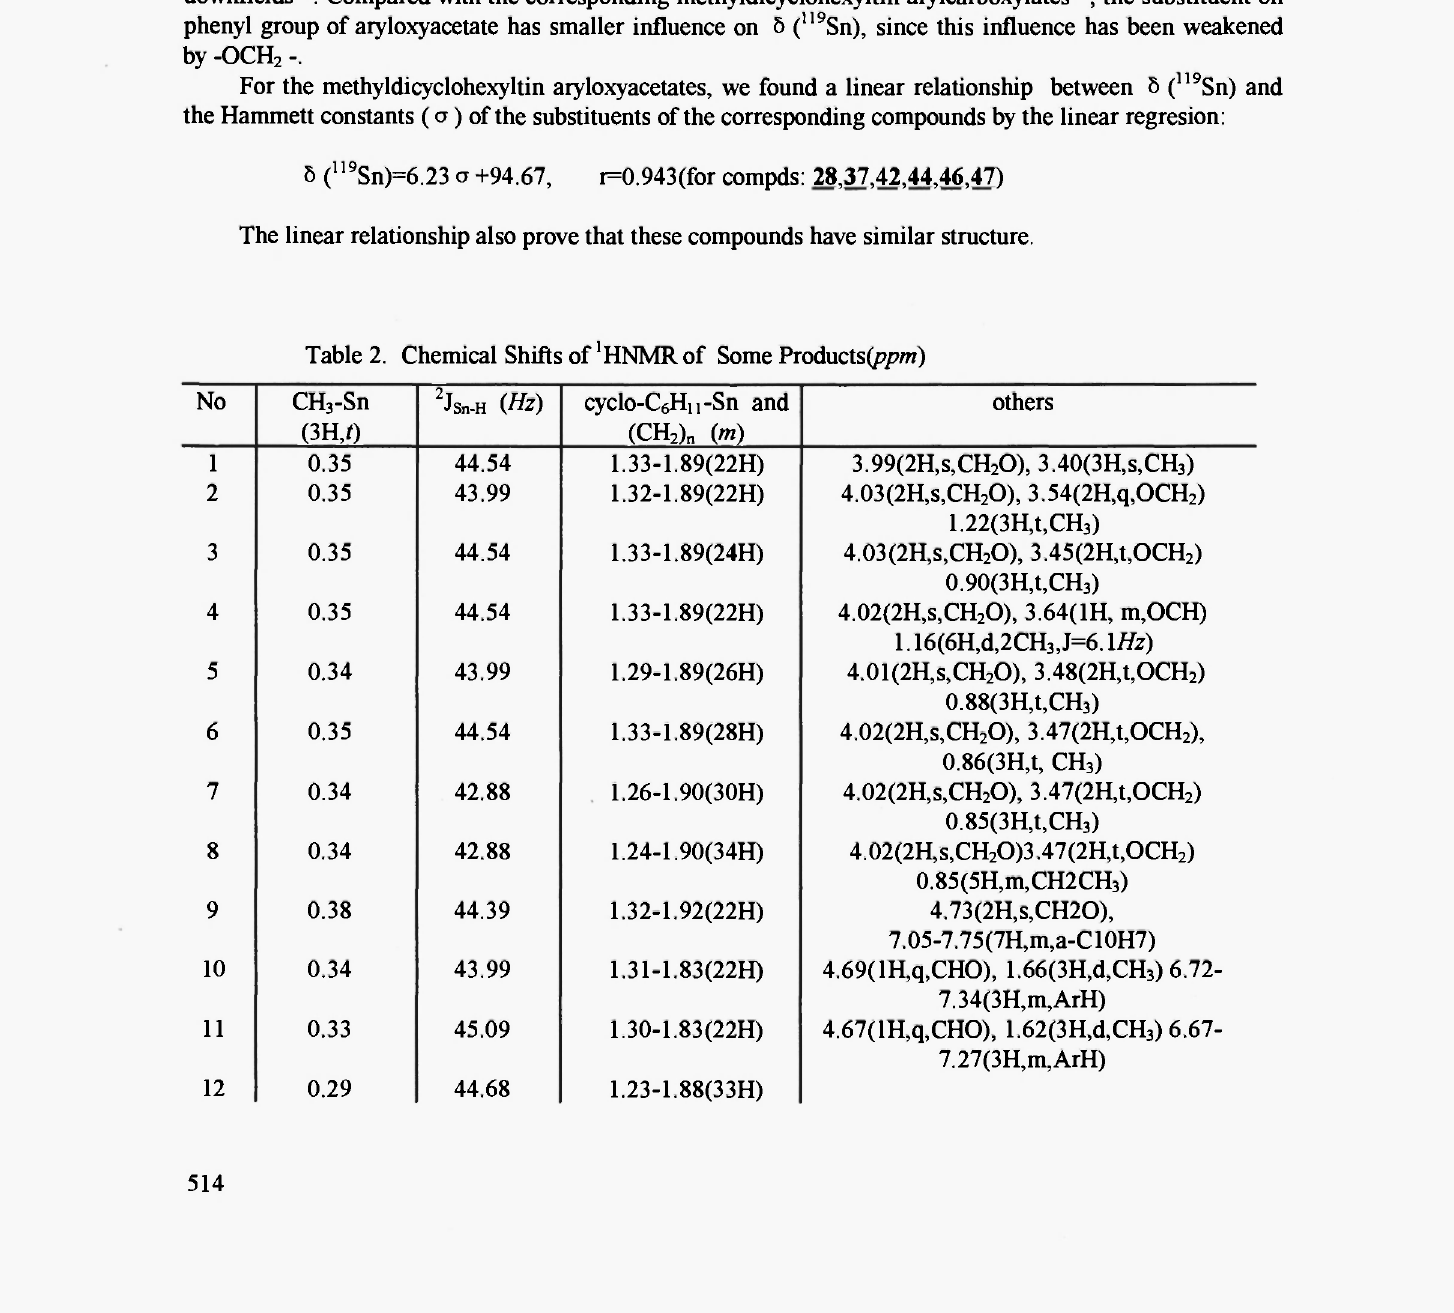
Table 2. Chemical Shifts of'HNMR of Some